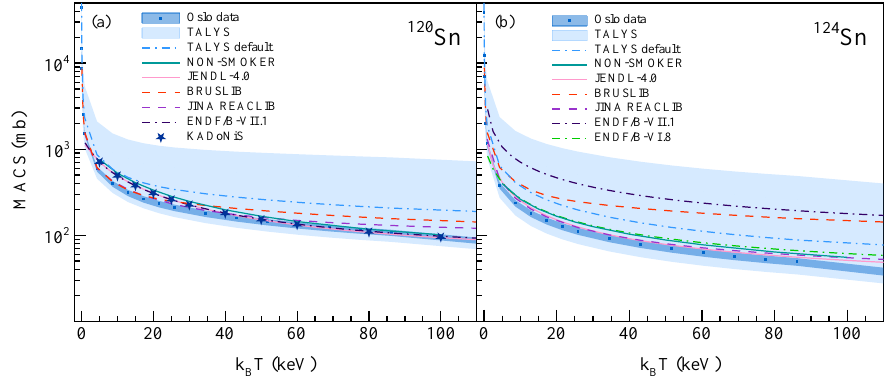
Figure 2. MACS of 119 , 123 Sn( n ,γ ) 120 , 124 Sn reactions obtained with the Oslo method input NLDs and GSFs compared to the span of TALYS predictions (light blue band), NON-SMOKER [13], JENDL-4.0 [14], BRUSLIB [15], JINA REACLIB [16], ENDF / B-VII.1 [17], ENDF / B-VI.8 [18], KADoNiS [19]